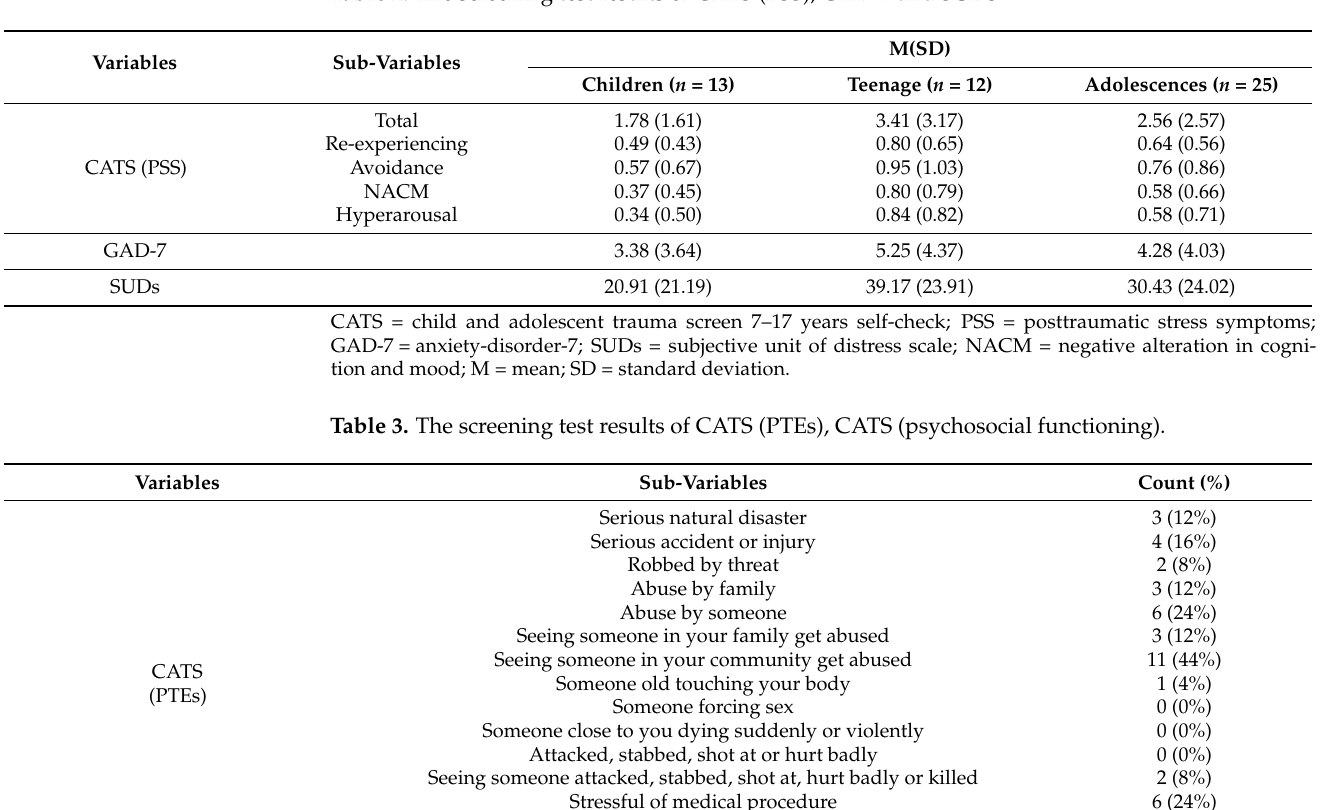
Table 2. The screening test results of CATS (PSS), GAD-7 and SUDs.